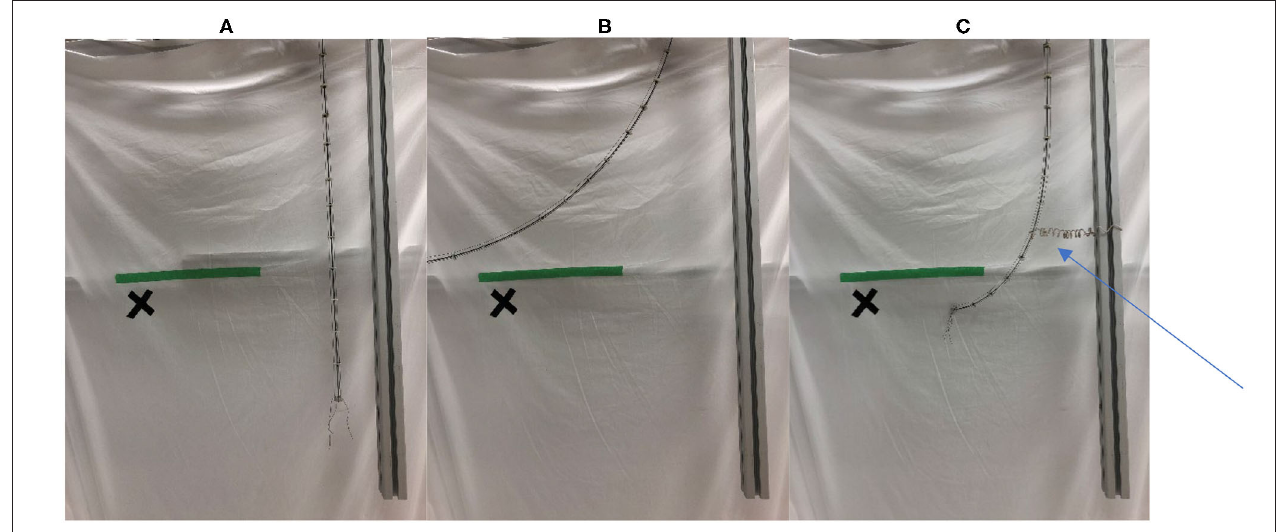
FIGURE 1 | (A) Robot “stem” (right), fixed vertical environmental structure (far right), target location for tip camera to view marked with “x.” (B) Bending of unconstrained stem. Bending is along entire backbone, tip and camera pass target (to its left). (C) Stem with robotic “tendril” attaching it (at arrow) to environmental structure. Searcher contact stabilizes stem-tendril, allowing greater bending at the tip, such that the tip camera is able to “see” the target. The green line represents a virtual obstacle.